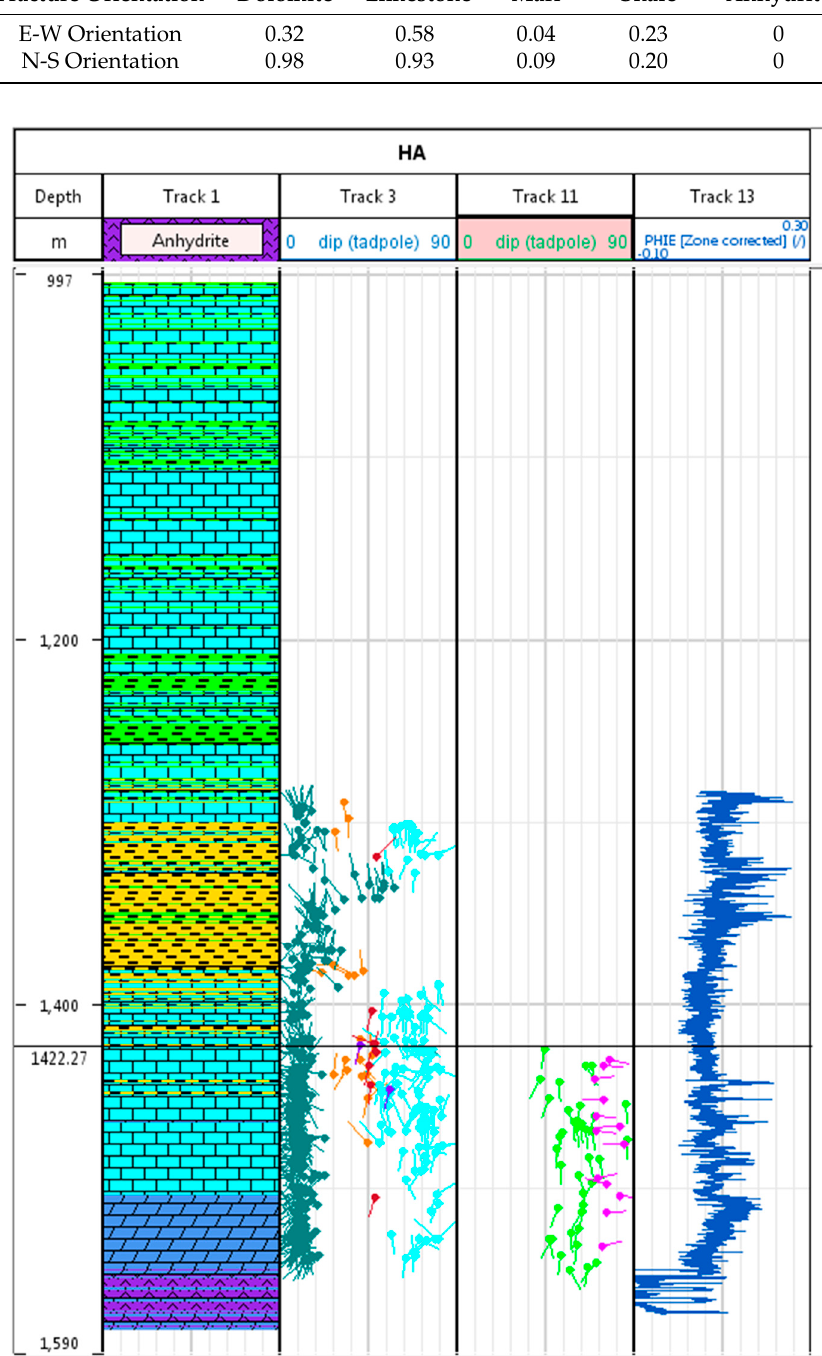
Figure 5. Facies, fracture dip (bedding in dark green), interpreted N-S (purple), and E-W (light green) fracture sets and porosity logs for HA